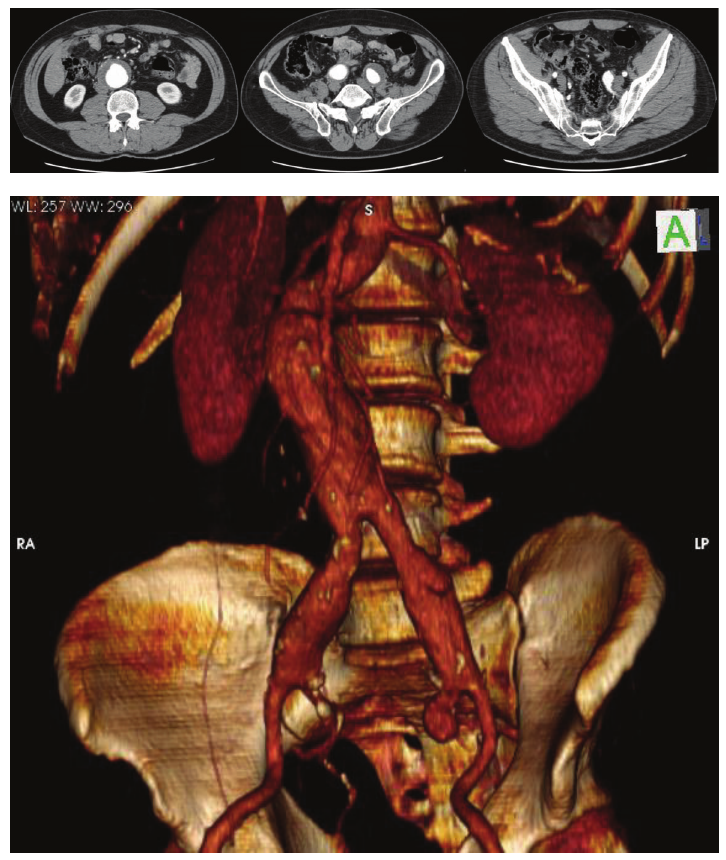
Figure 3: A 55-year-old patient with an AAA, bilateral common iliac, and left internal iliac artery aneurysms.